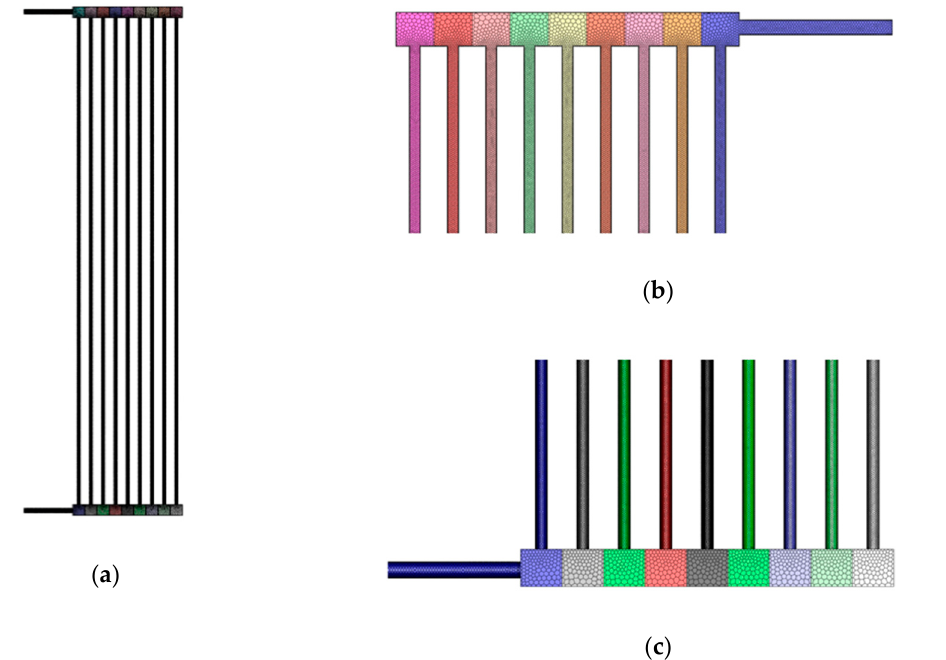
Figure 2. Three-dimensional (3D) polyhedral mesh using Fluent meshing: ( a ) full system; ( b ) combining manifold; ( c ) dividing manifold.